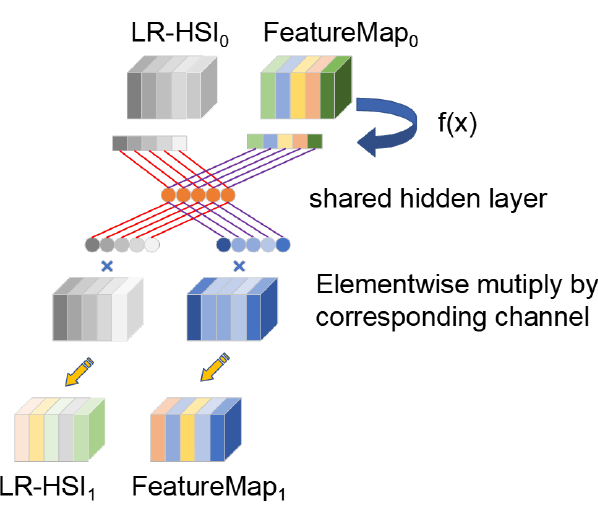
Figure 6. The schematic diagram of beta network